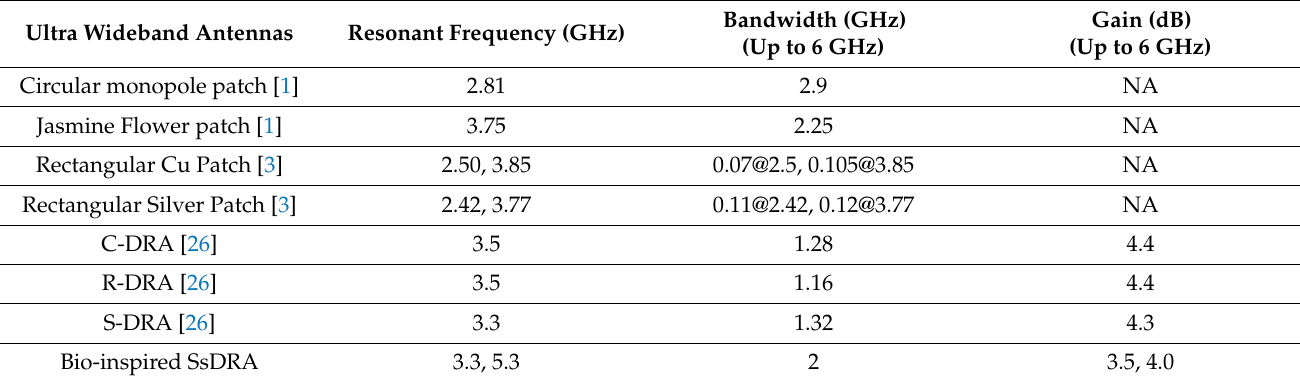
Table 4. Performance comparison of planar antennas and DRAs with various geometries: circular and modified bio-inspired patch antenna, regular rectangular patches with different metals, rectangular DRA (RDRA), cylindrical DRA (CDRA), star-shaped DRA, and bio-inspired